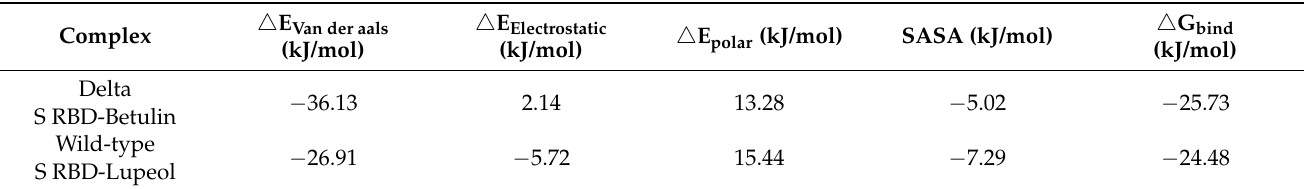
Figure 12. H-bonds plot showing the number of hydrogen bonds that stabilized the protein-ligand complexes of wild-type S RBD-Lupeol (black) and Delta S RBD-Betulin (red). Further, we performed a MM-PBSA analysis to calculate the thermodynamics parame- ters of the protein-ligand complexes, such as Van der Waals, electrostatic, polar solvation, SASA, and binding free energies (Table 3). The binding energy of the wild-type and Delta S RBD structures with the Lupeol and Betulin computed were − 25.73 kJ/mol and − 24.48 kJ/mol, respectively. These data together suggest that Lupeol and Betulin may bind with the S RBD of the two variants efficiently and therefore could be considered for further analysis. Table 3. Comparison of binding free energies and individual energies of Lupeol and Betulin calculated by